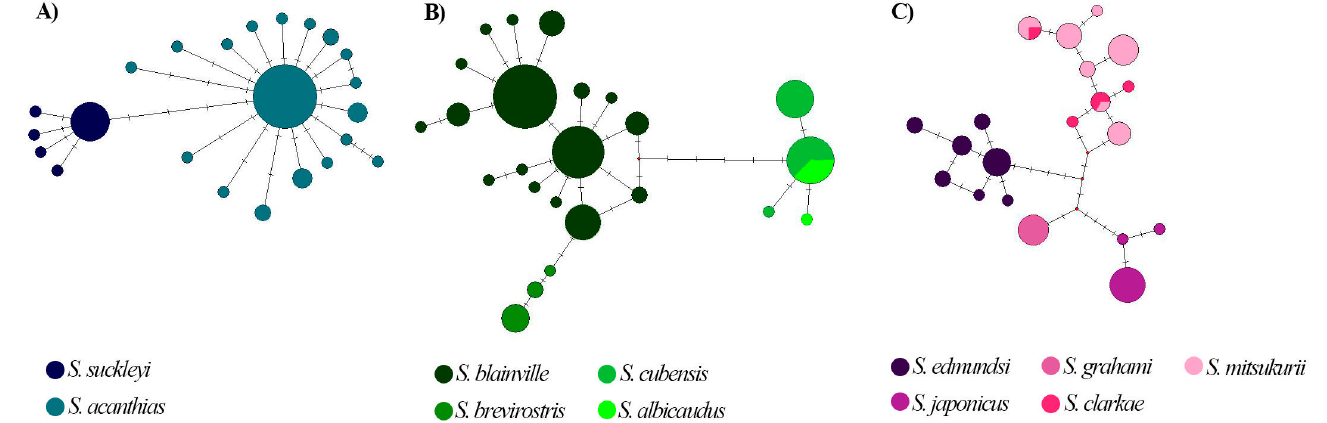
Figure 2. Median-joining network of the three identified groups based on COI gene sequencing from 11 nominal Squalus species: ( A ) group I, comprising S. suckleyi and S. acanthias ; ( B ) group II, consisting of S. blainville; S. brevirostris , S. cubensis , and S. albicaudus ; ( C ) group III, grouping S. edmundsi , S. japonicus , S. grahami , S. clarkae , and S. mitsukurii . The dashes represent mutational steps. The size of the circle representing each haplotype is proportional to the number of individuals within that haplotype. Table 2. Genetic distances (K2P) based on the division of MOTUs obtained through a PTP analysis among Squalus species (below the diagonal) and standard errors (above the diagonal). The numbers in bold represent the intraspecific K2P genetic